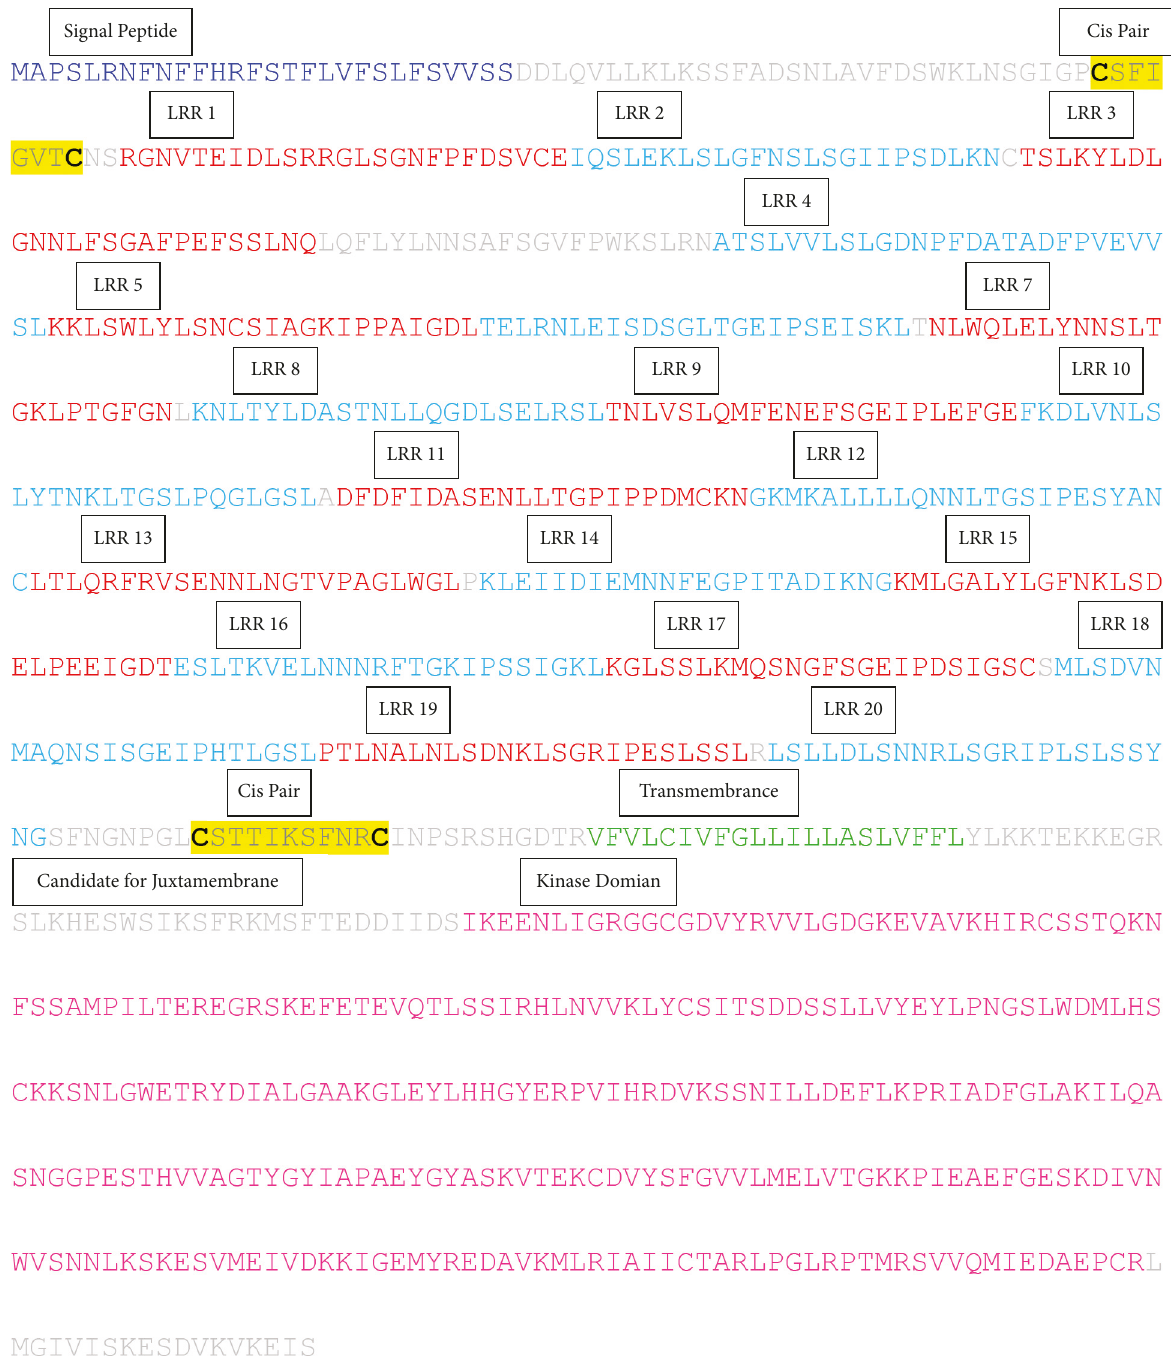
Figure 1: The amino acid sequence of RLK7. RLK7 carries a signal peptide, followed by an ectodomain composed of twenty LRRs, a transmembrane domain, a candidate for a juxtamembrane domain, and a kinase domain. The signal peptide is colored in blue, and the other twenty LRRs are colored in red and cyan alternatively. The transmembrane and kinase domains are colored in green and pink, respectively. The cysteine pairs that flanked the LRR domain are highlighted in